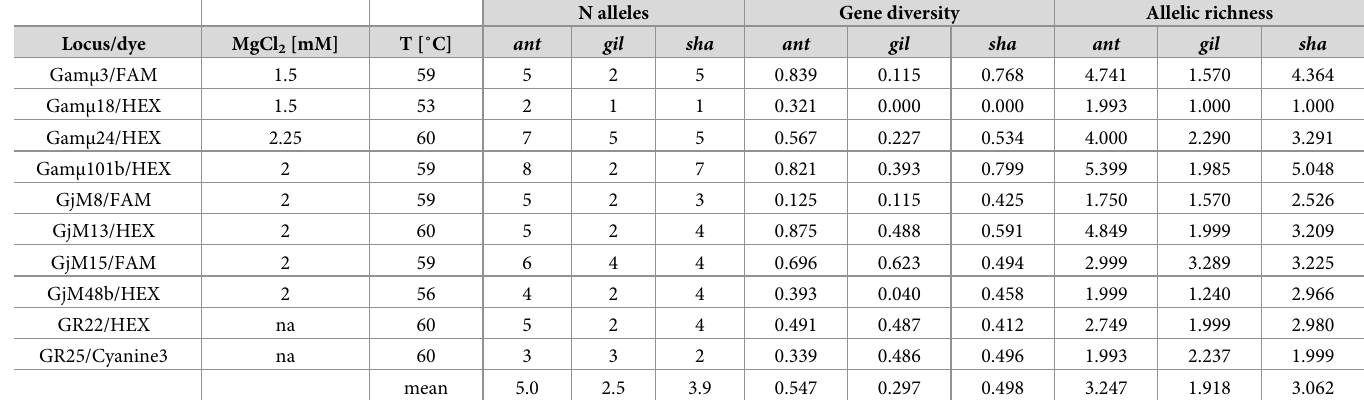
Table 3. PCR specifications and diversity of microsatellite loci. The subspecies are abbreviated by the first three letters ( ant : A . a . Antigone ; gil : A . a . gillae ; sha : A , a . sharpii